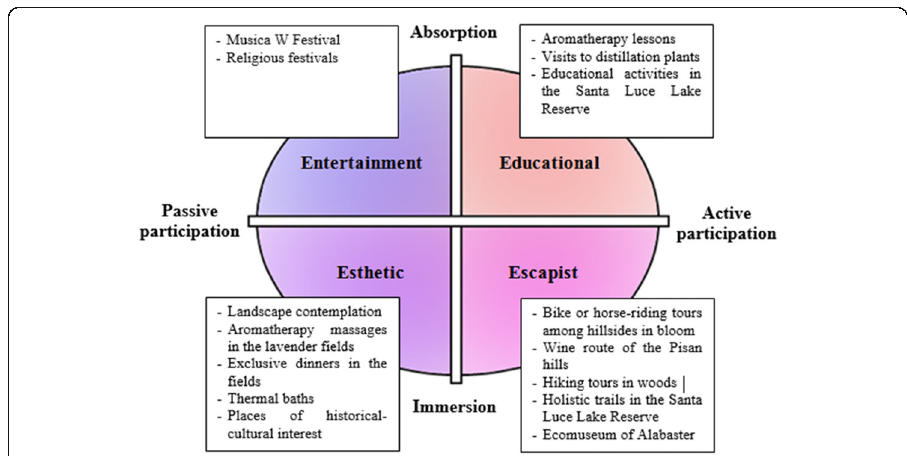
Fig. 2 Experiences categorization in the Perfume Valley. Source: our elaboration on Pine and Gilmore (1999)